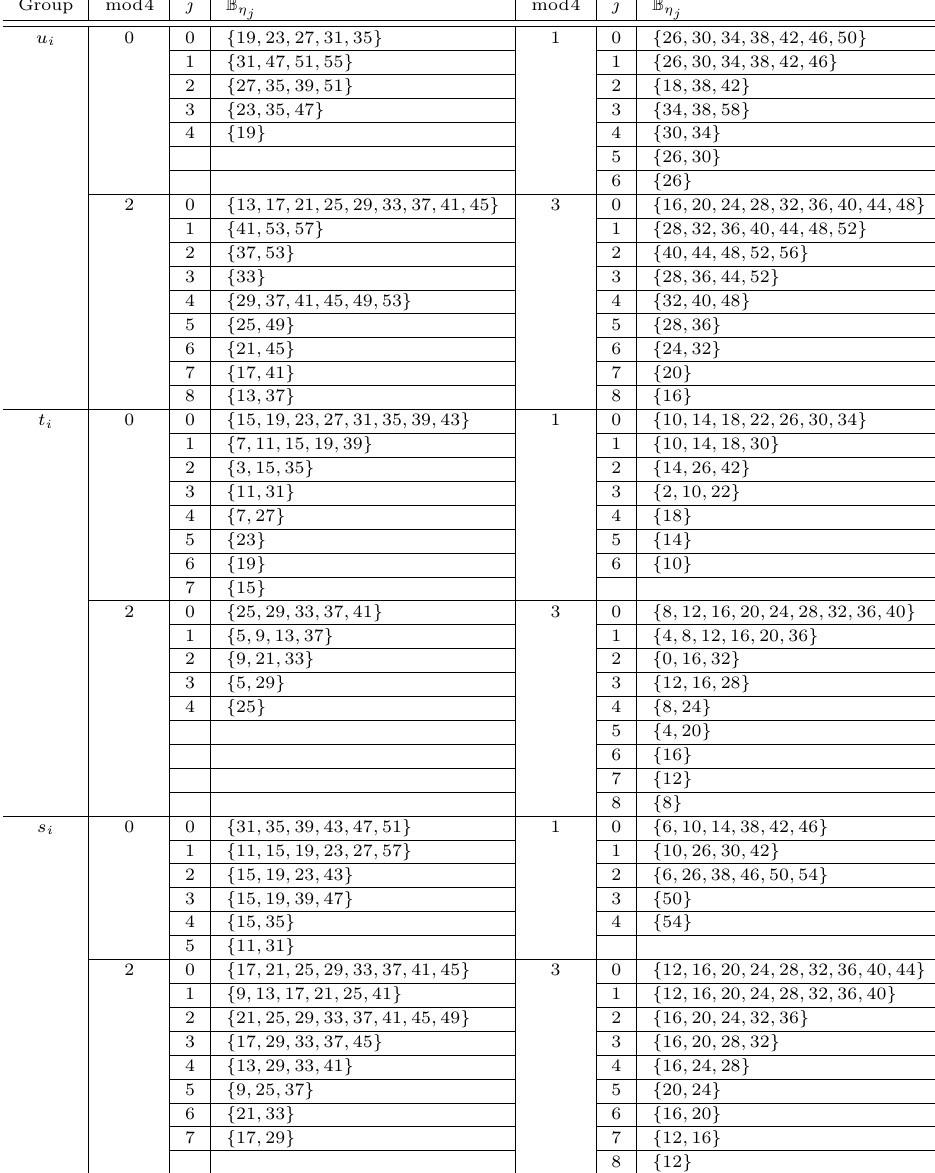
Table 13: Constructed B sets for the u i ’s, t i ’s and s i ’s in the GIFT permutation Group